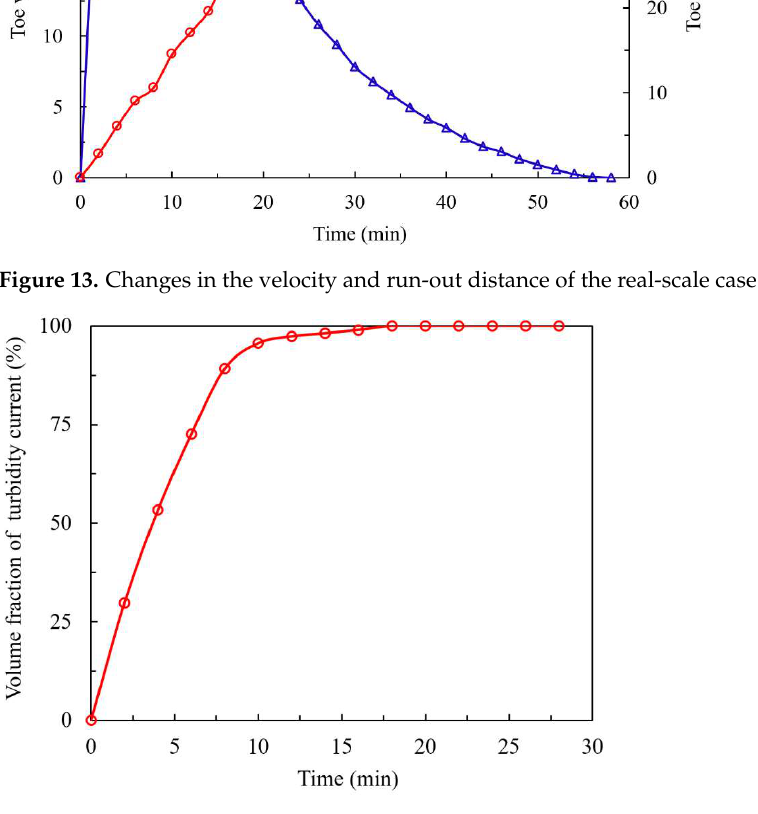
Figure 14. Change in the transformation ratio T throughout the whole process.